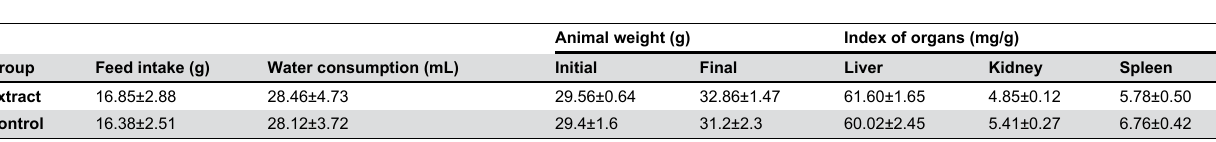
Table 4. Effect of M. oleifera aqueous seed extract (2000 mg/kg) on physiological parameters of mice 14 days after